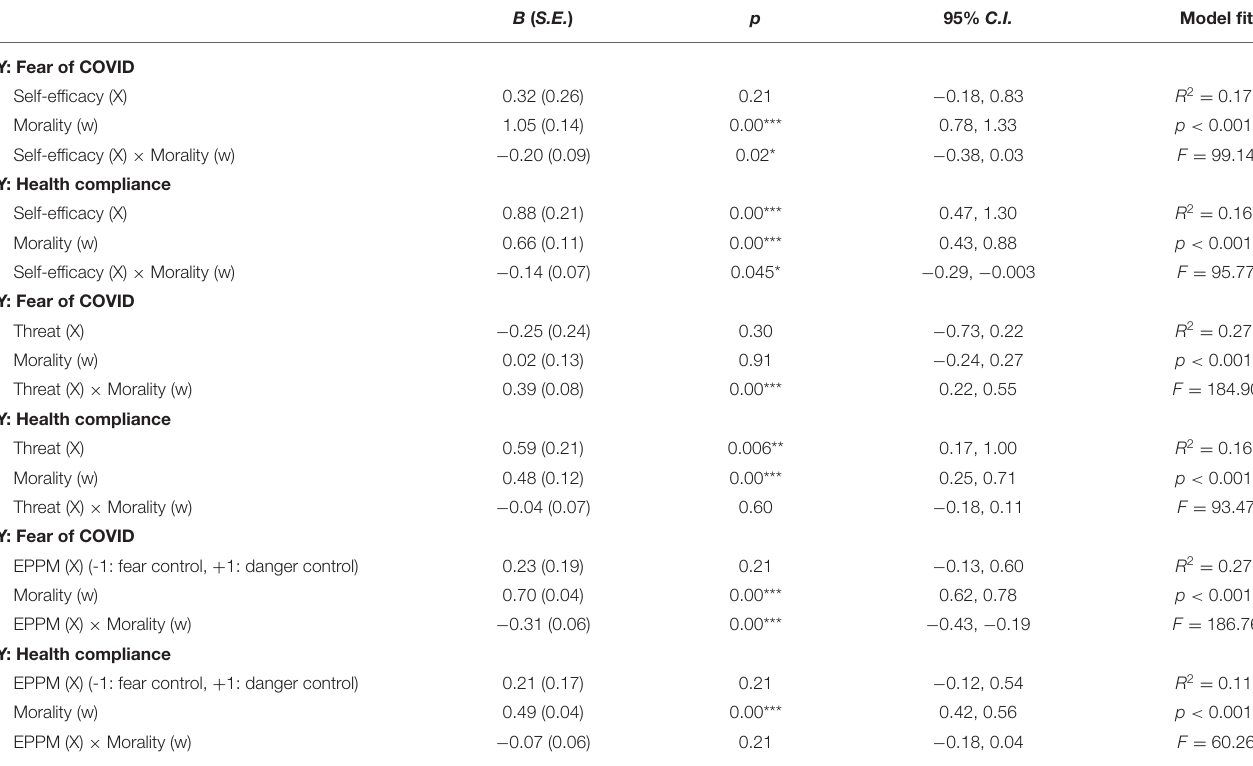
TABLE 1 | Summary of PROCESS v.3.5.3 moderation testing (model = 1, bootstrap = 5,000, conditional effects = − 1 SD, M , and + 1 SD). B ( S.E. ) 95%